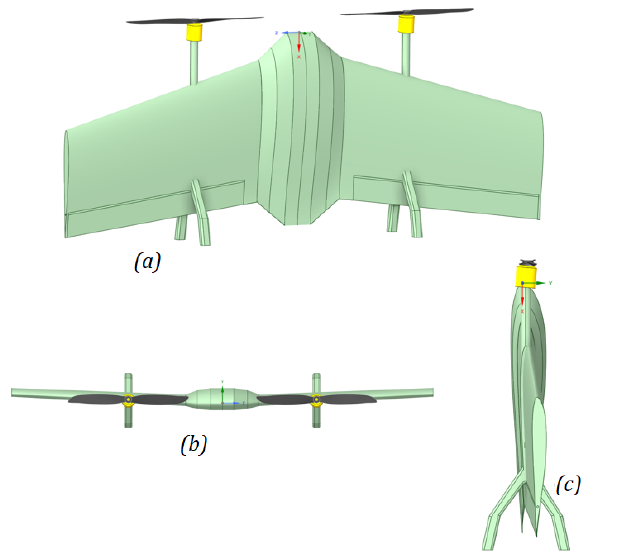
Figure 10. Virtual prototype of the tail-sitter: ( a ) Top view. ( b ) Front view. ( c ) Side